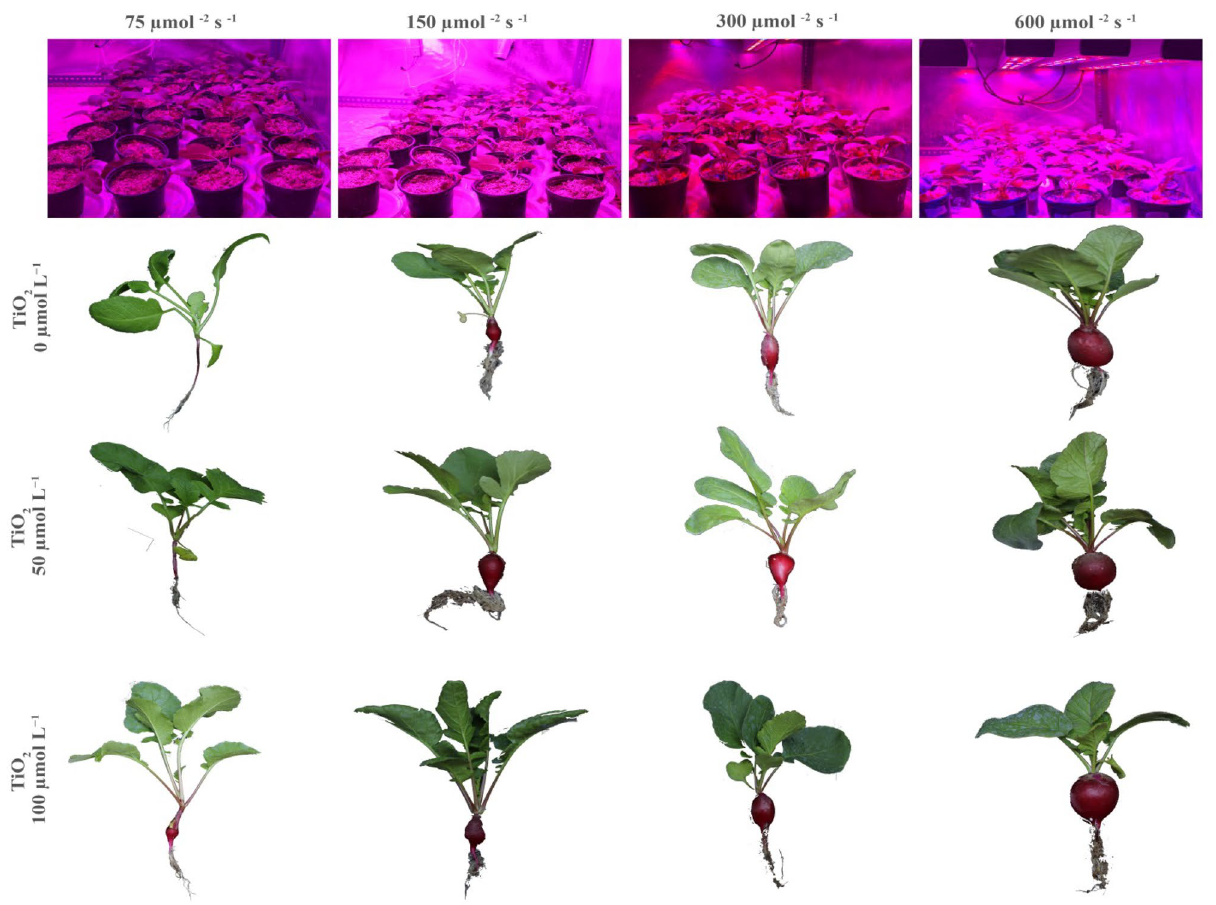
Figure 2. The growth environment (top panels), and representative images of radish cv. Cherry belle plants cultivated under different light intensities and sprayed (once a week, and three times in total) with titanium dioxide (TiO 2 ) nanoparticles at different levels.